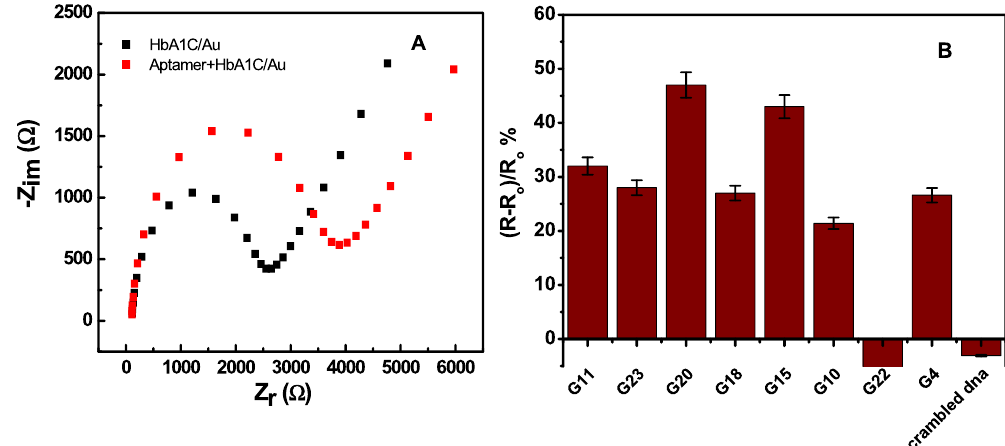
Figure 1. ( A ) Example of Nyquist plots of the HbA1c-modified gold electrodes before (black) and after (red) aptamer binding. ( B ) Binding assays with individual aptamer sequences to HbA1c-modified